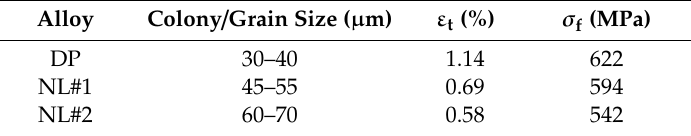
Table 2. The microstructure characteristics and mechanical properties of di ff erent TNM